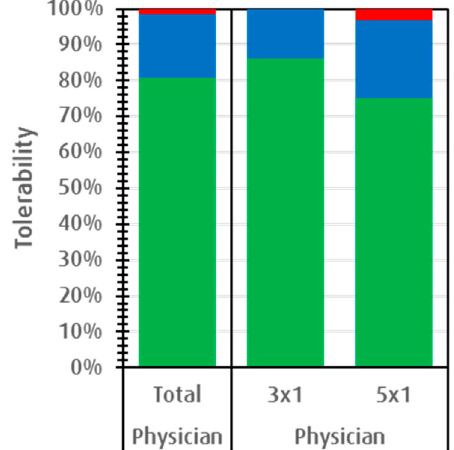
Figure 2. The primary endpoint of “tolerability assessed by physician” in the total safety collective and in each dosage group. Green indicates “very good”, blue “good”, and red “poor”.